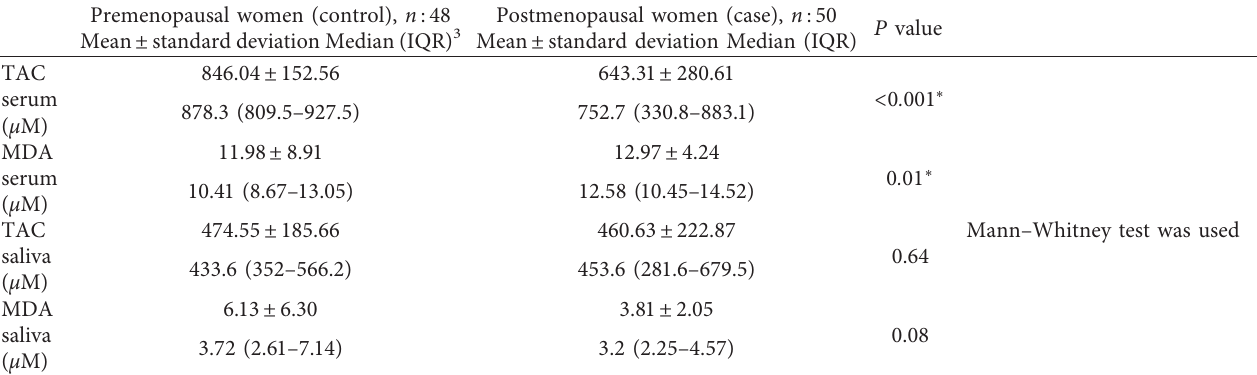
Table 1: TAC 1 and MDA 2 of saliva and serum of the postmenopausal and premenopausal women. Premenopausal women (control), n :48 Mean ± standard deviation Median (IQR)